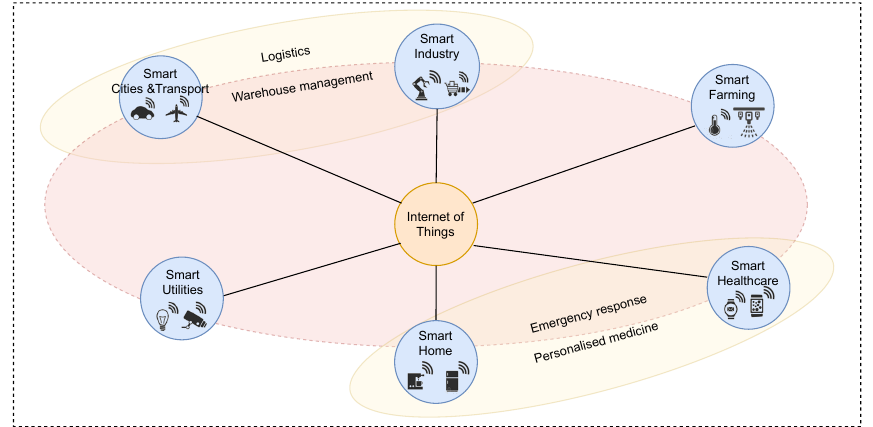
Figure 1. Data-shared IoT (Internet of Things)